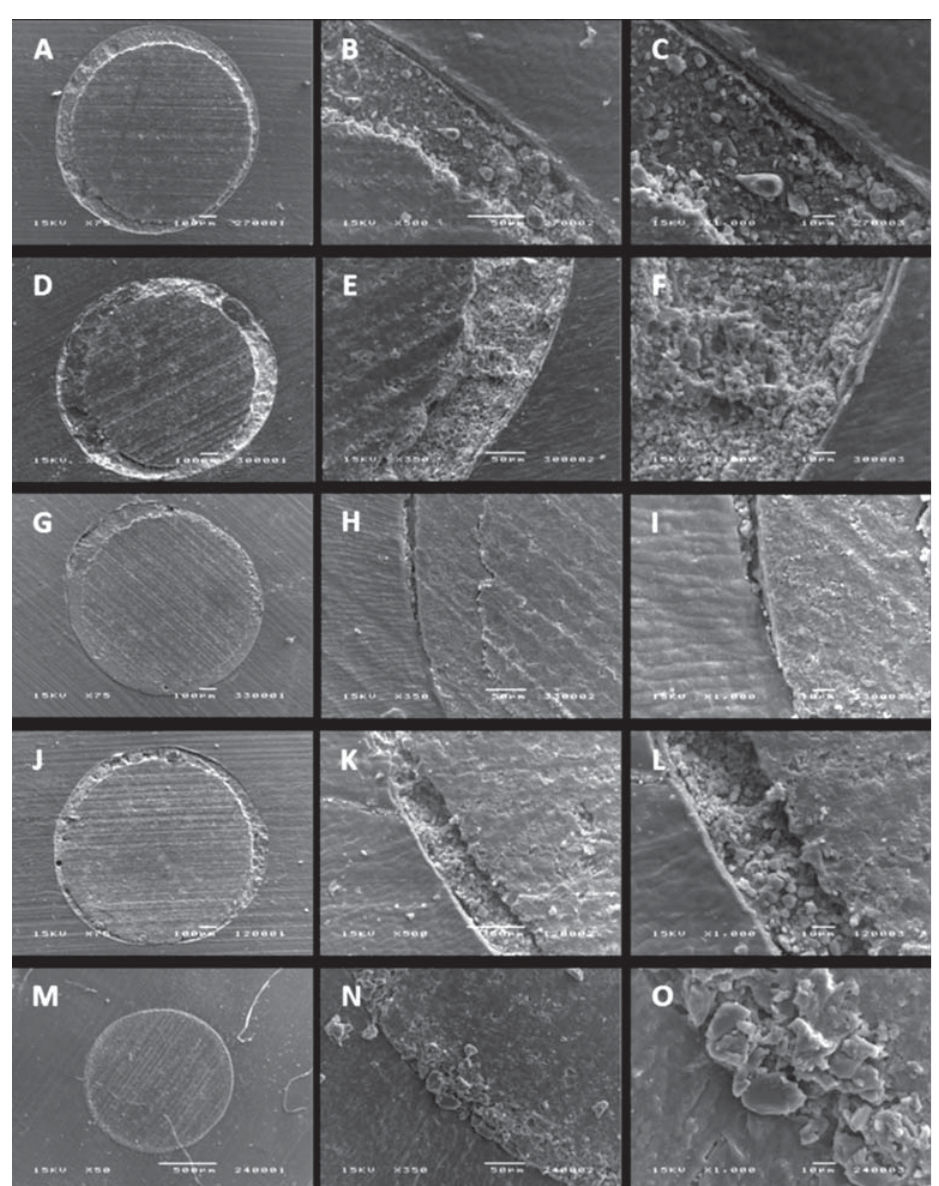
Figure 2 - (cid:13)(cid:28)(cid:26)(cid:16)(cid:7)(cid:7)(cid:6)(cid:7)(cid:14)(cid:13)(cid:4)(cid:15)(cid:4)(cid:26)(cid:18)(cid:19)(cid:10)(cid:7)(cid:13)(cid:9)(cid:6)(cid:26)(cid:19)(cid:10)(cid:5)(cid:26)(cid:10)(cid:23)(cid:29)(cid:13)(cid:23)(cid:30)(cid:10)(cid:18)(cid:10)(cid:9)(cid:6)(cid:26)(cid:19)(cid:10)(cid:14)(cid:19)(cid:16)(cid:23)(cid:30)(cid:5)(cid:13)(cid:10)(cid:24)(cid:13)(cid:12)(cid:31)(cid:4)(cid:19)(cid:13)(cid:23)(cid:10)(cid:5)(cid:18)!(cid:26)(cid:4)(cid:9)(cid:4)(cid:7)(cid:18)(cid:13)(cid:16)(cid:7)(cid:11)(cid:13)(cid:26)(cid:4)(cid:9)(cid:4)(cid:7)(cid:18)!(cid:11)(cid:4)(cid:7)(cid:18)(cid:6)(cid:7)(cid:13)(cid:6)(cid:7)(cid:18)(cid:4)(cid:19)(cid:24)(cid:16)(cid:26)(cid:4)(cid:5)(cid:27)(cid:13)(cid:2)"(cid:20)(cid:13)#(cid:20)(cid:13)$%(cid:13) Luting & Lining Cement; (D, E, F) Fuji II Cement LC Improved; (G, H, I) RelyX Luting; (J, K, L) Ketac Cem; and (M, N, O)